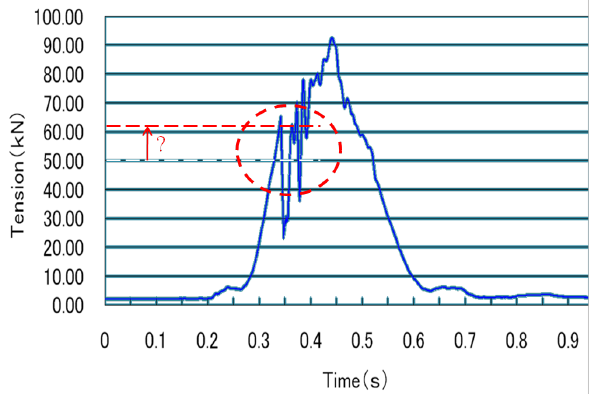
Fig. 15. The instrumented time history of maximum tension in cable (at M in Fig. 1) in the FST of the R-LPR, in relation to the detection of the possible flaw under discussion. The dotted circle in the figure emphasizes the portion of the time history when the device must have slipped. The lower dotted horizontal line indicates the designated level of slip-tension (i.e. 50kN) while the upper dotted horizontal line represents the level of actual slip-tension likely to have occured in the FST as inferred from the discontinuity in the history.